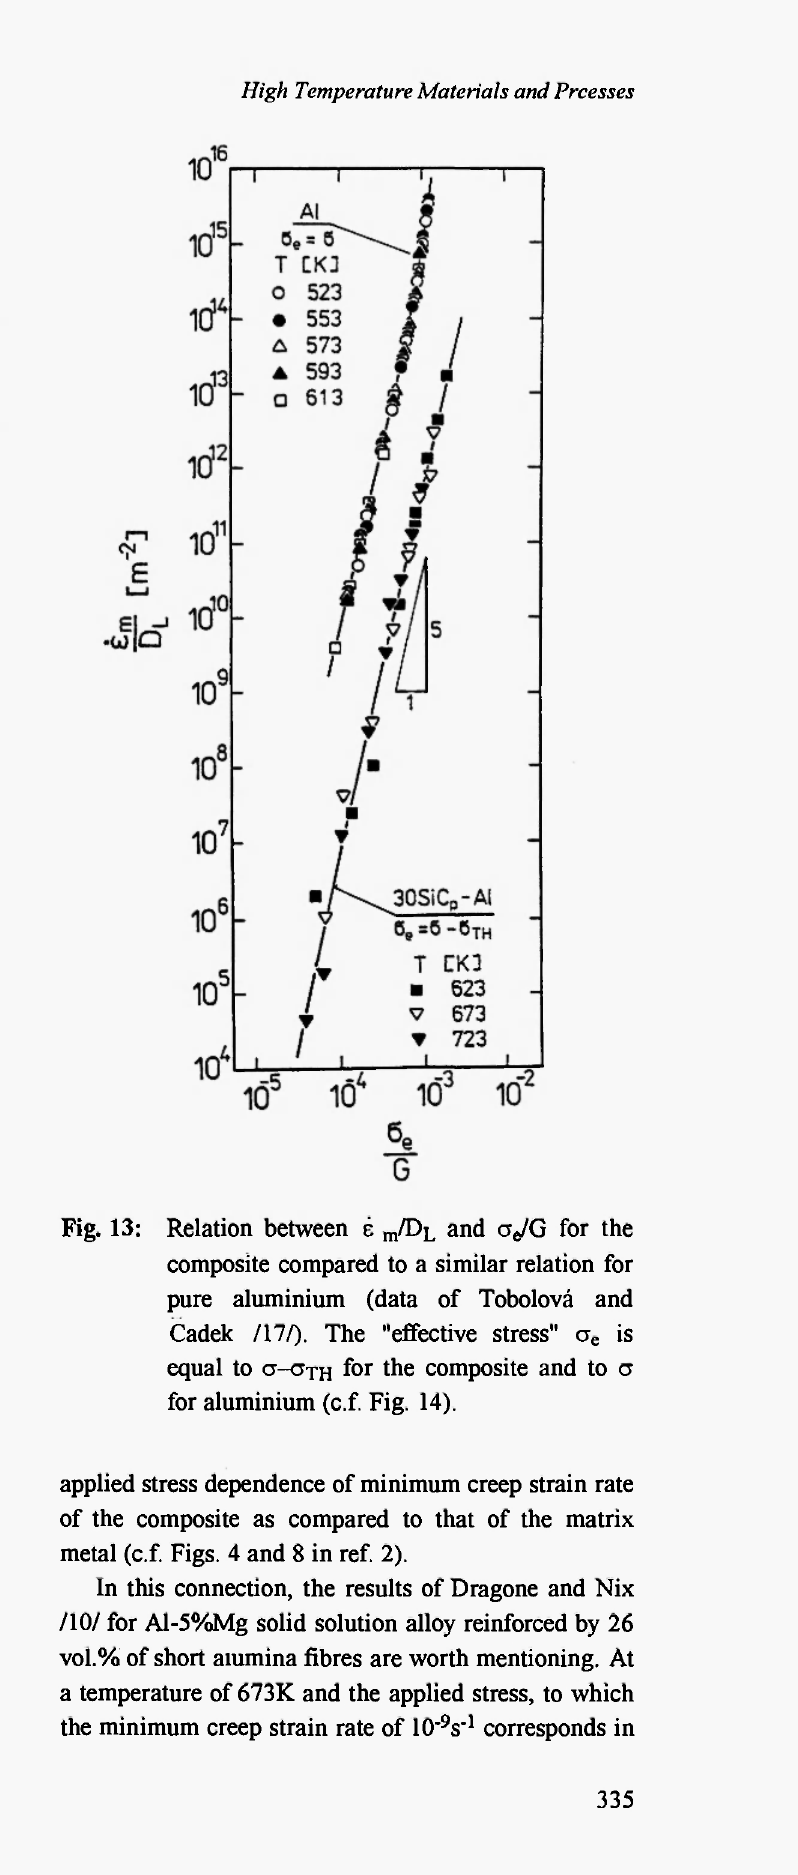
/D and oJG for the m L